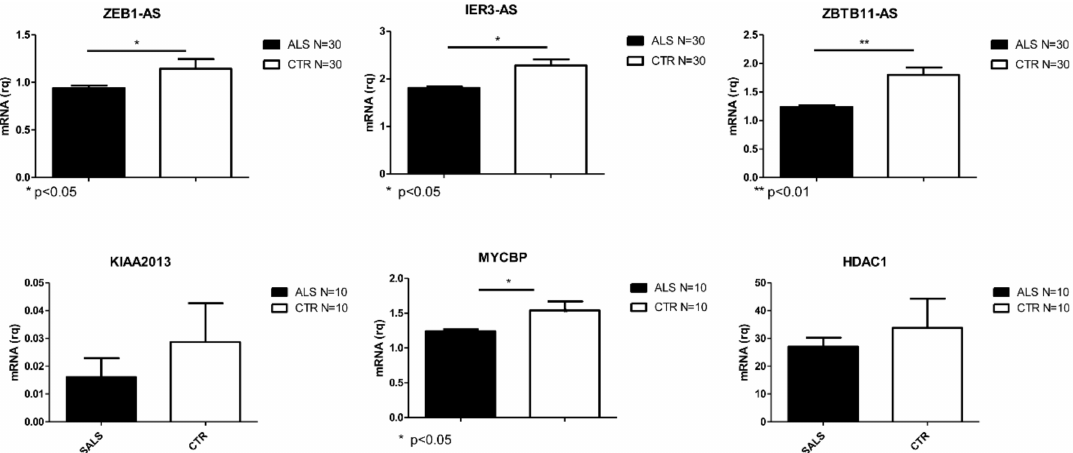
Figure 2. Di ff erentially expressed transcripts verified by Real Time PCR in PBMCs from a larger cohort of SALS and CTRLs (N = 30 for lncRNAs and N = 10 for coding RNAs. * p < 0.05, ** p < 0.001 vs.